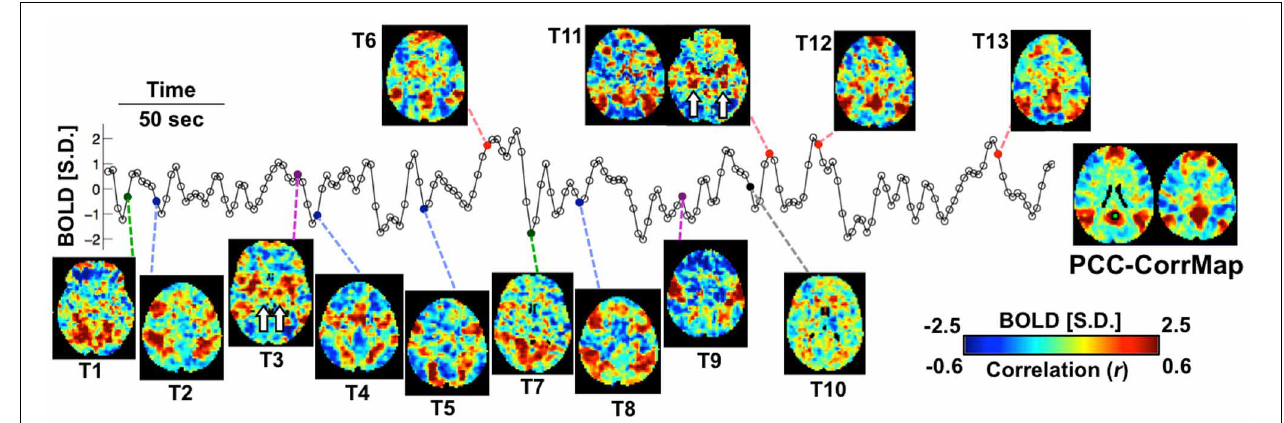
FIGURE 1 | Spontaneous activity at single fMRI time frames is suggestive of varying network involvement. Sample frames (T1-T13) from a representative fMRI scan show clear, distinct spatial patterns, some of which (red points) resemble the DMN pattern demonstrated by the PCC-based correlation map of this subject (right). The fMRI time course